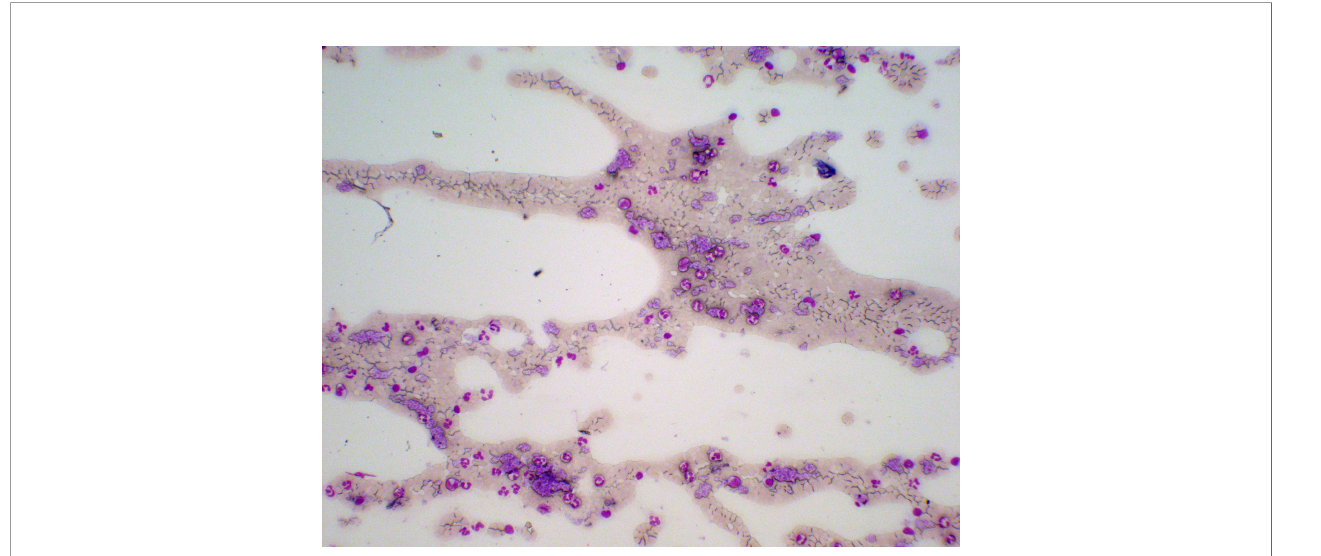
FIGURE 4 | Panoramic screenshot of the peripheral blood (PB) smear “ tail ” on May-Grunwald-Giemsa (MGG) staining (100× magni fi cation). Platelet aggregates, neutrophil granulocytes, lymphocytes, and monocytes (normal cells of the peripheral blood) of PB smear on MGG staining (400× magni fi cation).